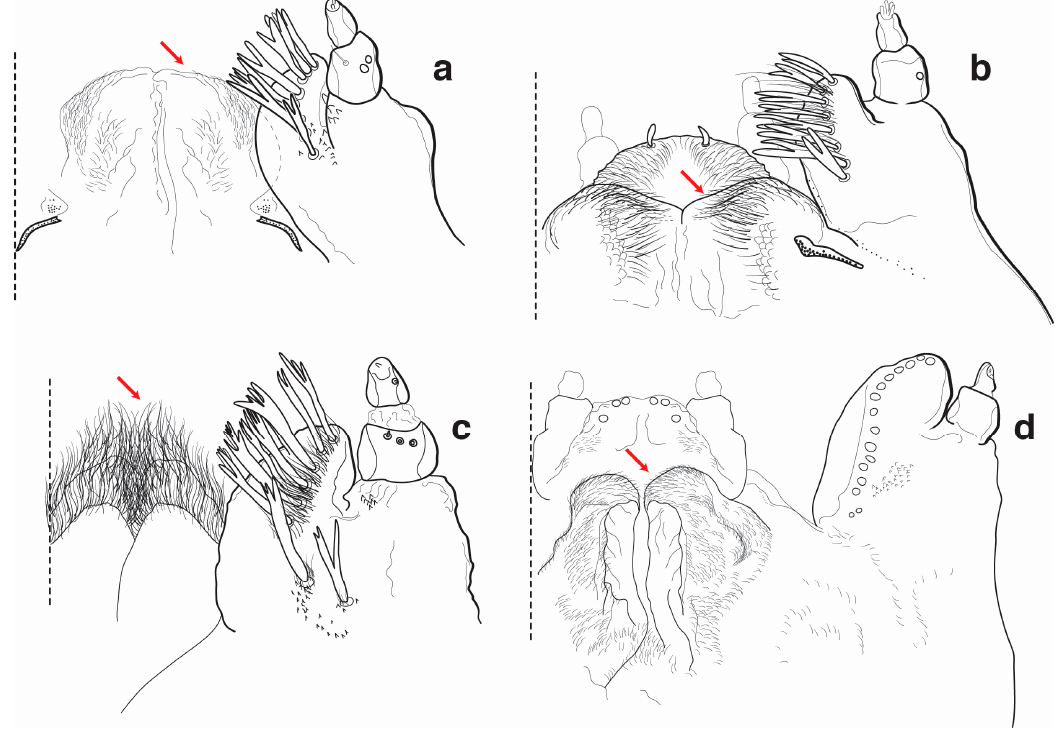
Figure 40. Hypopharynx, mala, and maxillary palp, larva, dorsal view: ( a ) Diocalandra ; ( b ) Polytus ; ( c ) Temnoschoita ; and ( d ) Sipalinus